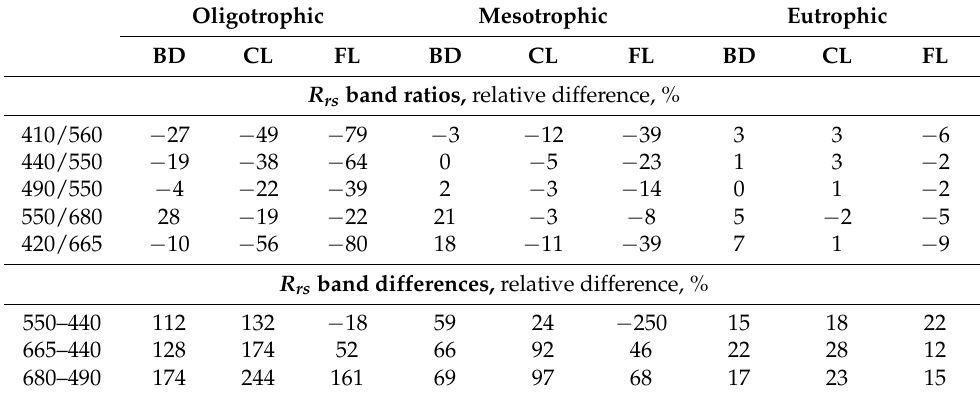
Table 2. Percentage relative differences between R rs band ratios and band differences received for unpolluted ocean waters and polluted by three kinds of dispersed oils: biodiesel BD, lubricant oil CL and crude oil